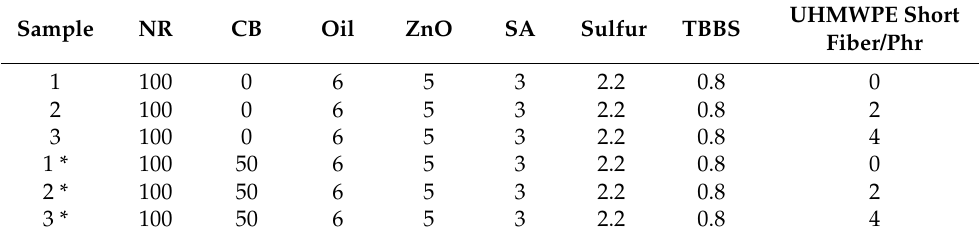
Table 1. Compounding formulation of NR/UHMWPE short